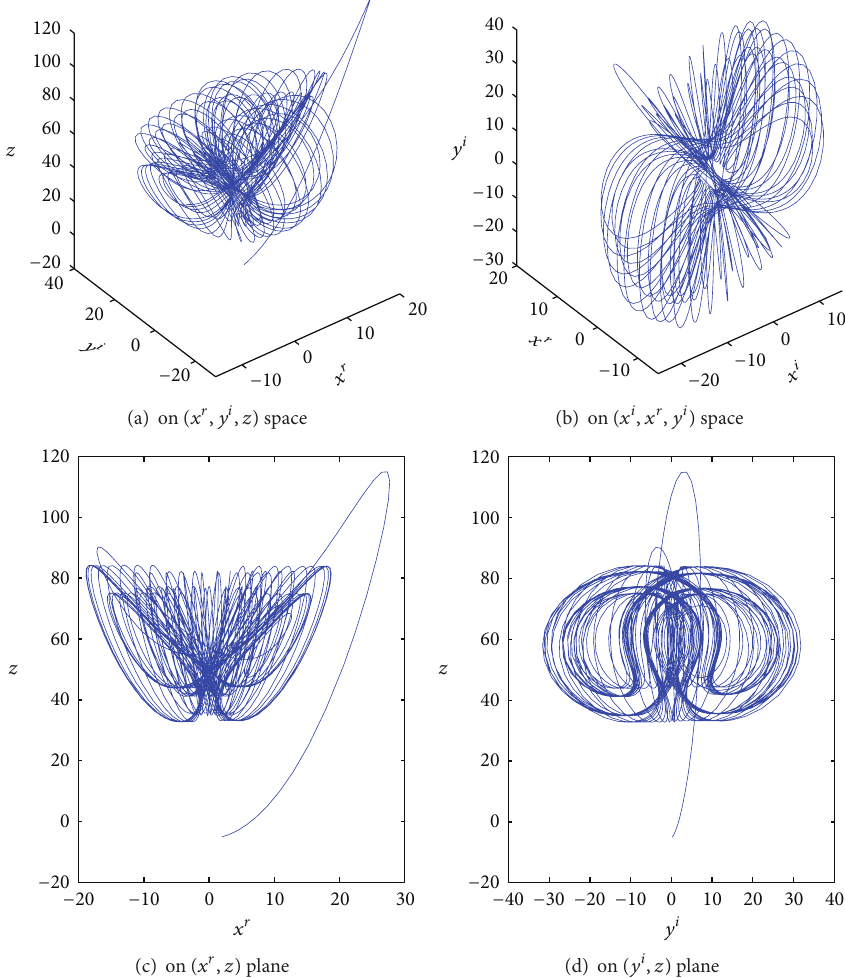
Figure 1: The attractors of complex chaotic Lorenz system (2) with complex parameters 𝜎 = 5 , 𝑟 = 60 + 0.2𝑗 , 𝑎 = 1 − 0.6𝑗 , and 𝑏 = 1.8 and initial values 𝑥(0) = 2 + 0.2𝑗 , 𝑦(0) = 15 + 0.2𝑗 , and 𝑧(0) = −5